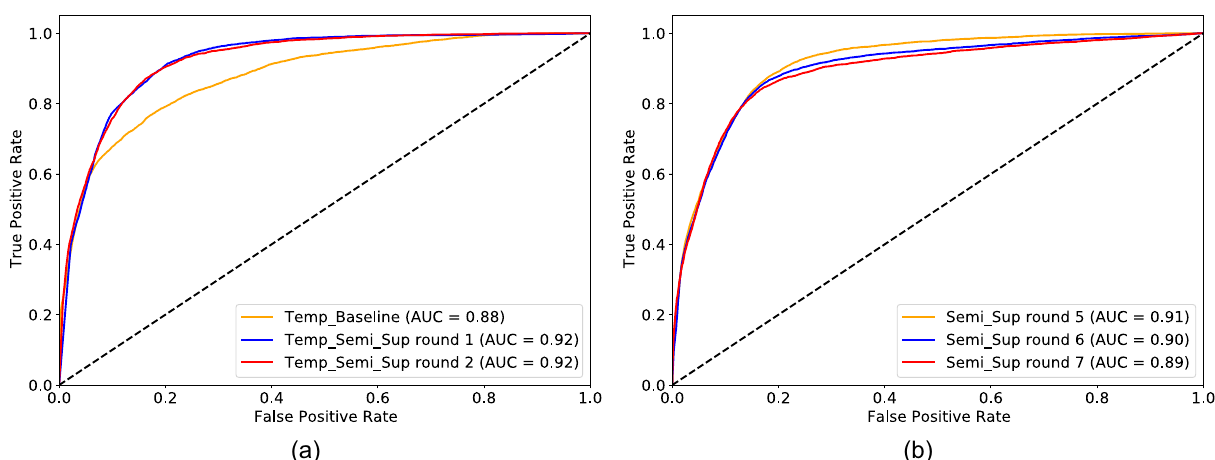
Figure 8. ROC curves of the convLSTM model ( a ) and 2D CNN ( b ) trained on the entire Training-300K dataset. Both models were fine-tuned from the Semi-sup 4 model (Fig. 7a). Three SSL rounds were repeated for both models.